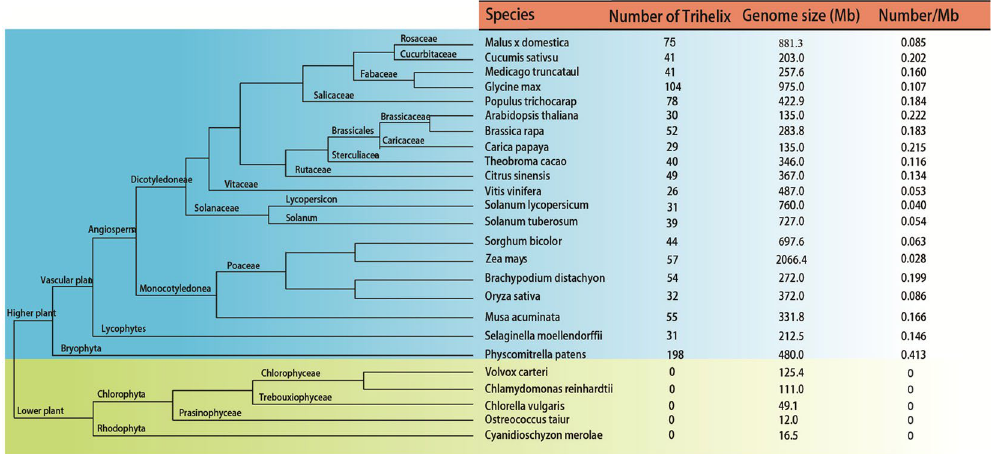
Figure 1. The relationships of the species and the number detail of the trihelix family of each species. The left of this figure shows the categories of the species; the right of this figure shows the number detail of the trihelix family of each